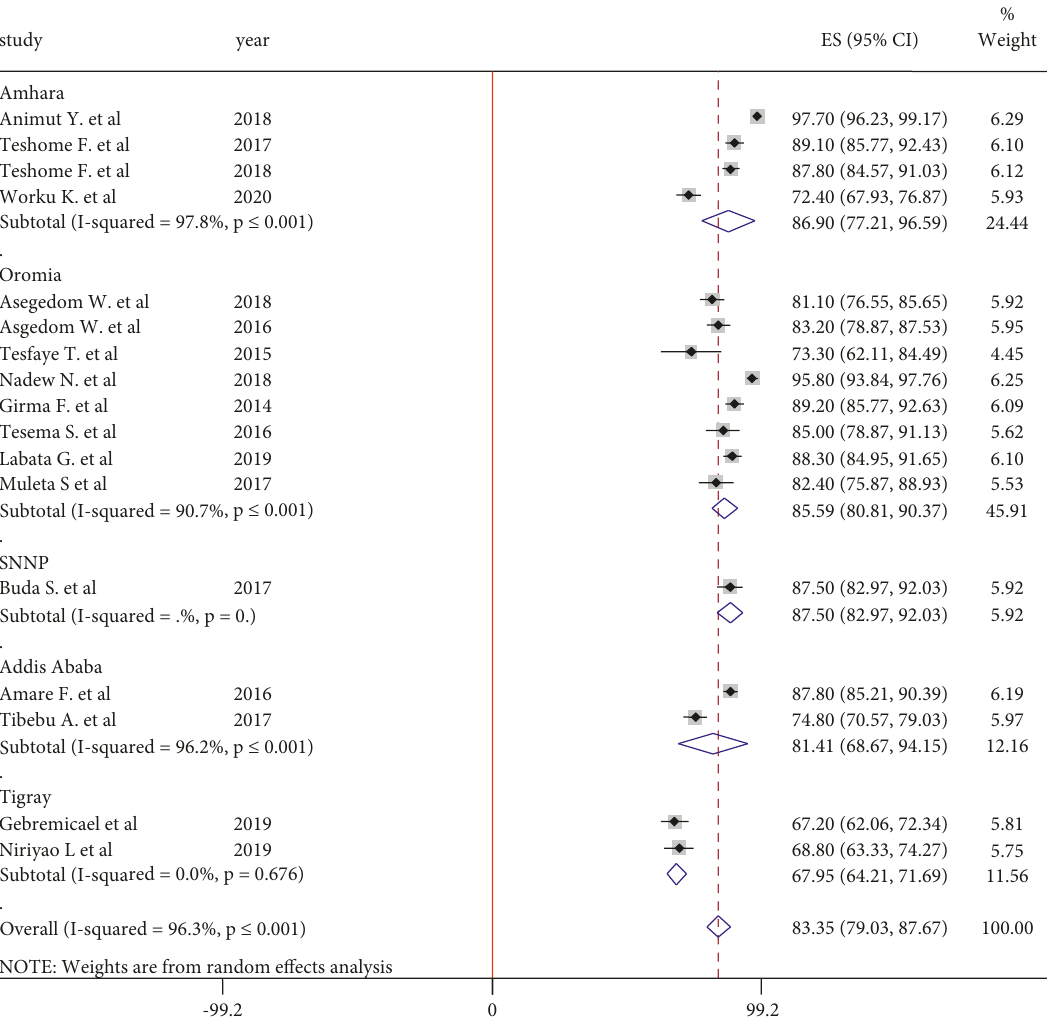
Figure 8: Forest plot on adherence to alcohol abstinence among hypertensive patients in